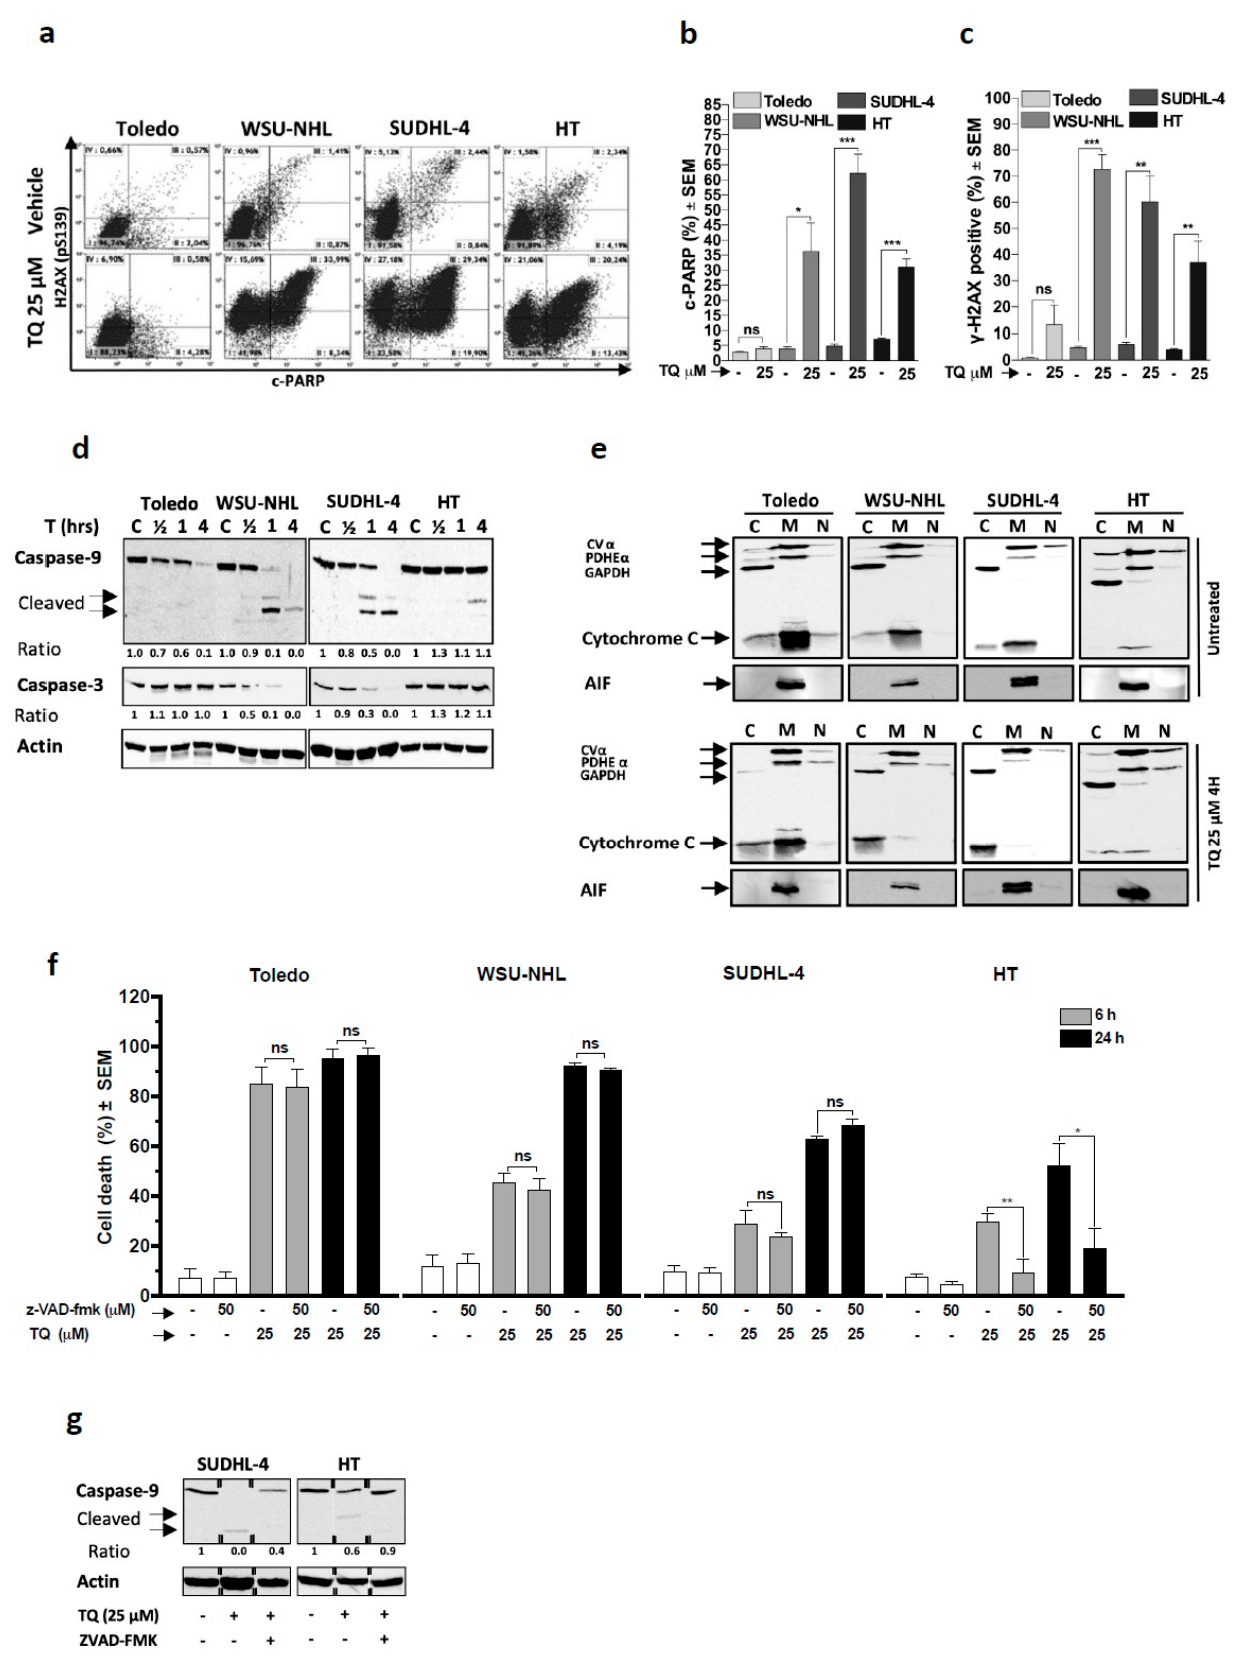
Figure 2. Role of the apoptotic pathway in the TQ-induced cell death effect: ( a – c ) Effect of TQ on apoptosis and DNA damage: Cell lines were treated with 25 µ M TQ for 4 h and then immunostained with antibodies targeting